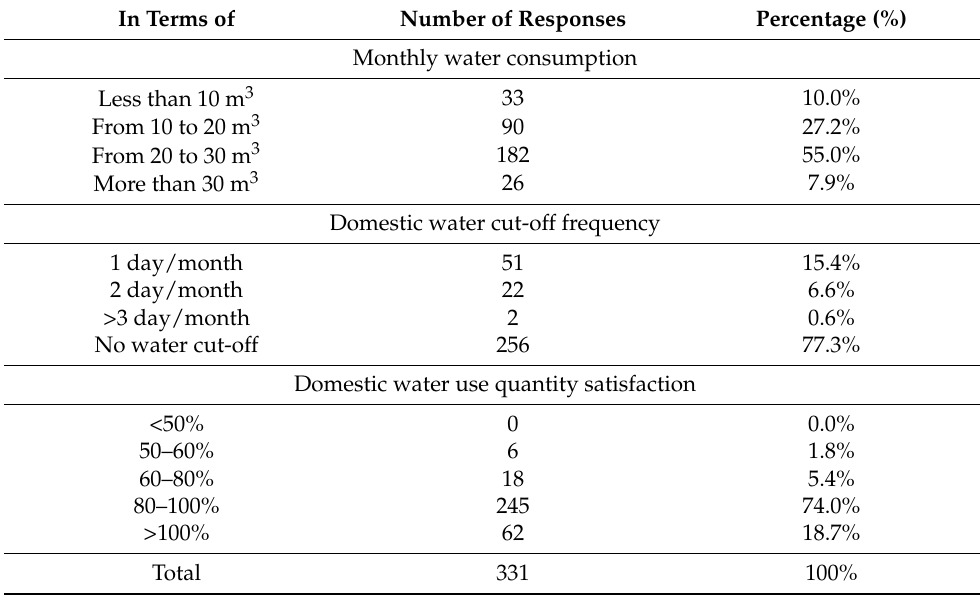
Table 3. Household responses regarding domestic water